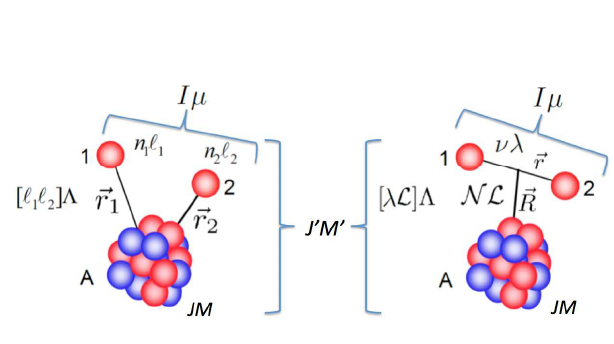
Figure 2. Illustration of the surrogate reaction method. Here, d interacts with D to form the required compound nucleus B ∗ . d may be scattered inelastically or may gain or lose nucleons to form b . Figure 3.